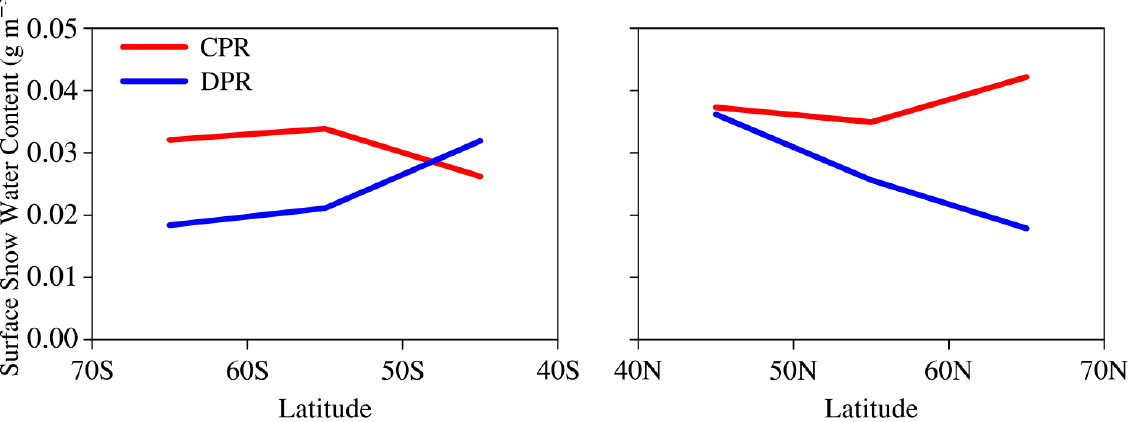
Figure 6. Zonally mean surface snow water contents for CPR and DPR in 10° latitude band over oceans.